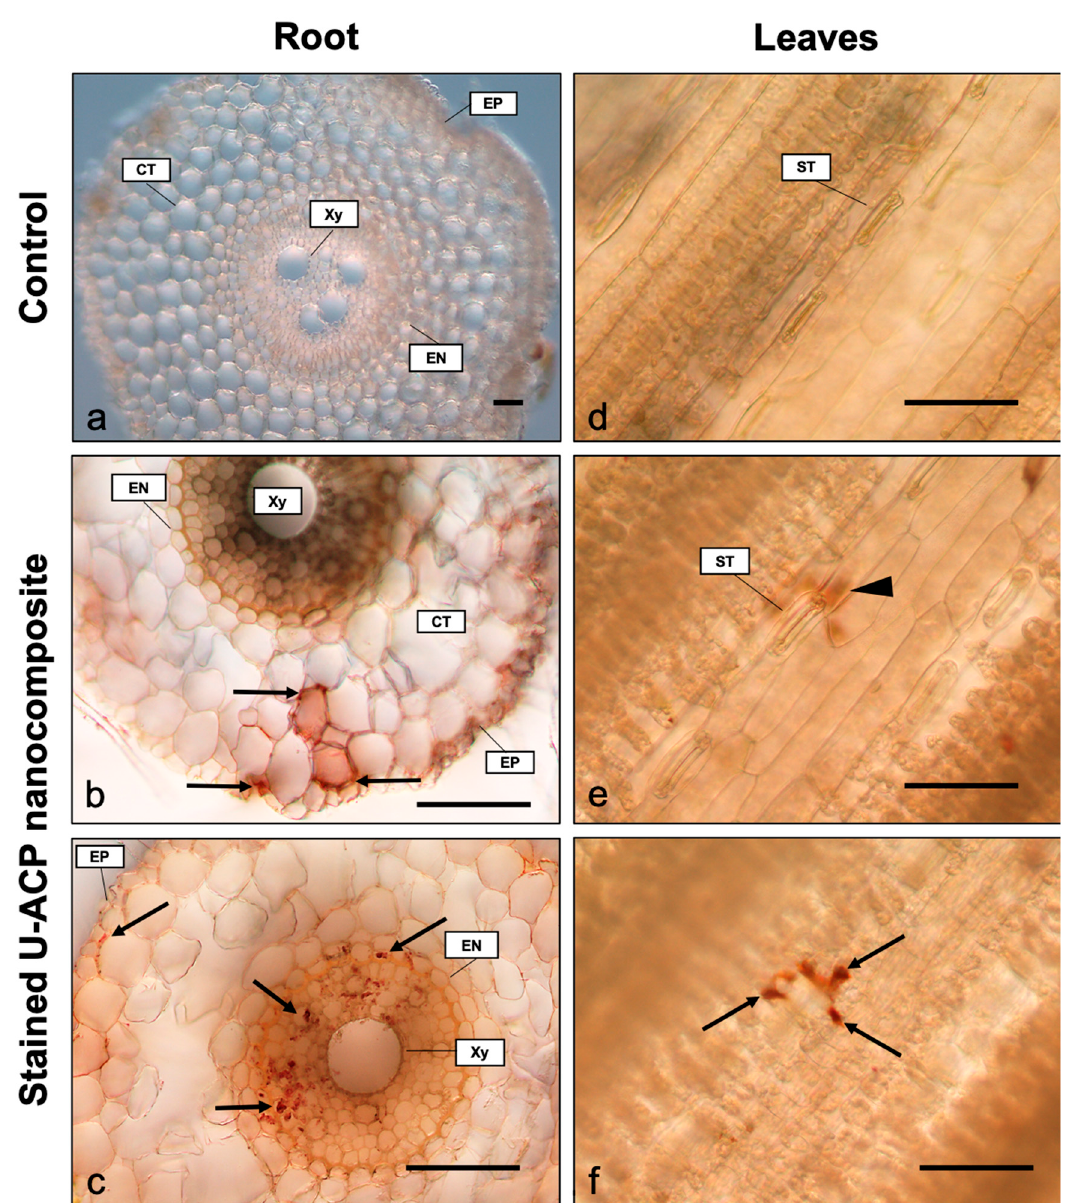
Figure 6. Histological localization of U-ACP nanocomposites inside wheat plants. Hand sections of wheat root ( a , b , c ) and leaf samples ( d , e , f ). Non-exposed controls show the absence of nanoparticles either in roots (a) and leaves (d). Accumulation of Alizarin Red S stained nanocomposites (arrows) can be observed in the apoplast of the root cortex (b) and inside the symplast of the central cylinder (c). In leaves, the presence of nanoparticles under the epidermis is first seen as an out of focus red-brownish stain (arrowhead) under the stomata (e), appearing as micro-sized aggregates (arrows) in the stomatal cavity when the plane is in focus (f). Note that (e) and (f) correspond to the same observation point with di ff erent focal planes. Scale bar = 50 µ m. CT—cortex; Xy—xylem; EN—endodermis; EP—epidermis;